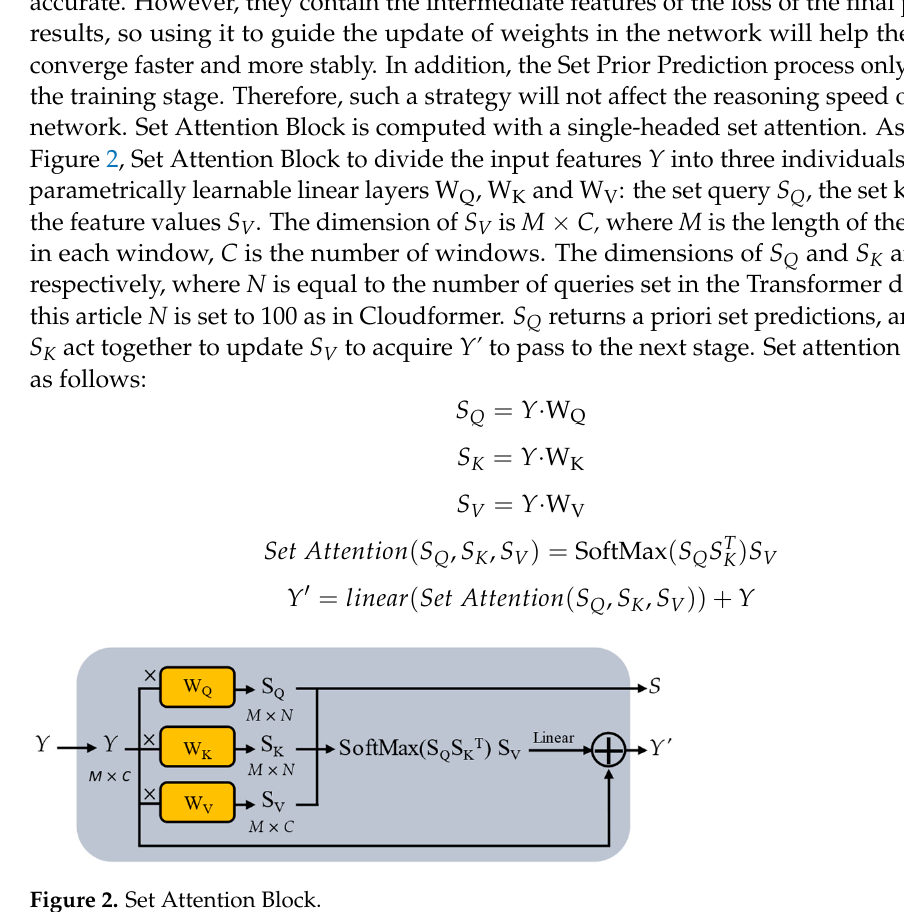
Figure 2. Set Attention Block.